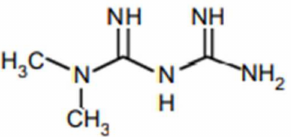
Figure 1. Molecular structure of